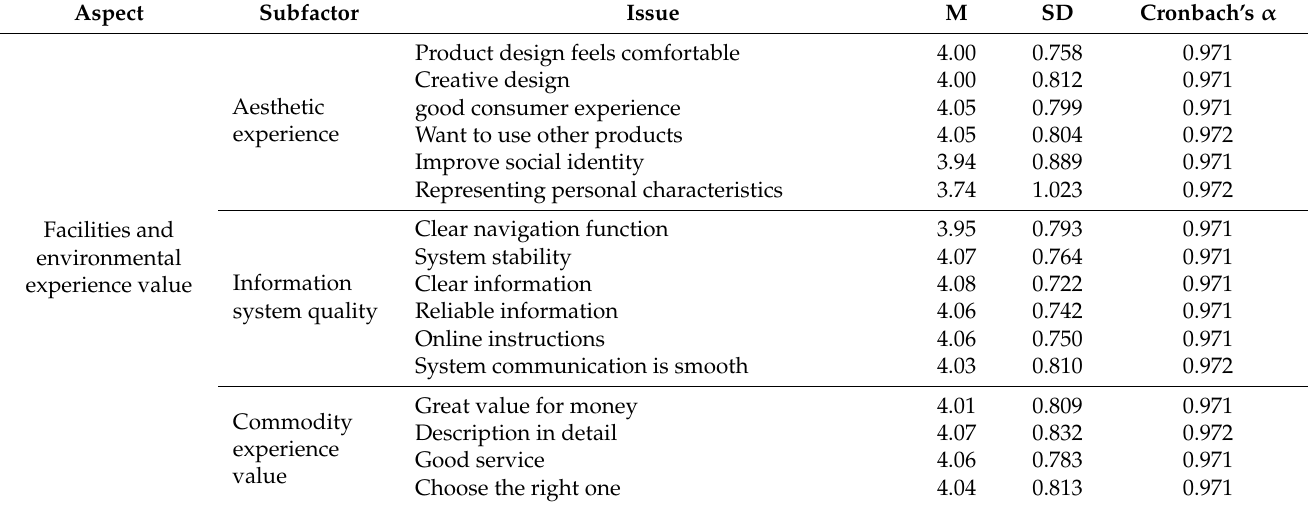
Table 2. Questionnaire analysis form of facility experience value, leisure involvement, leisure satisfaction and well- being